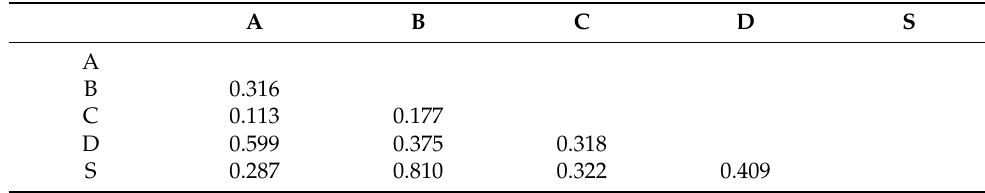
Table 6. HTMT ratios of correlations.